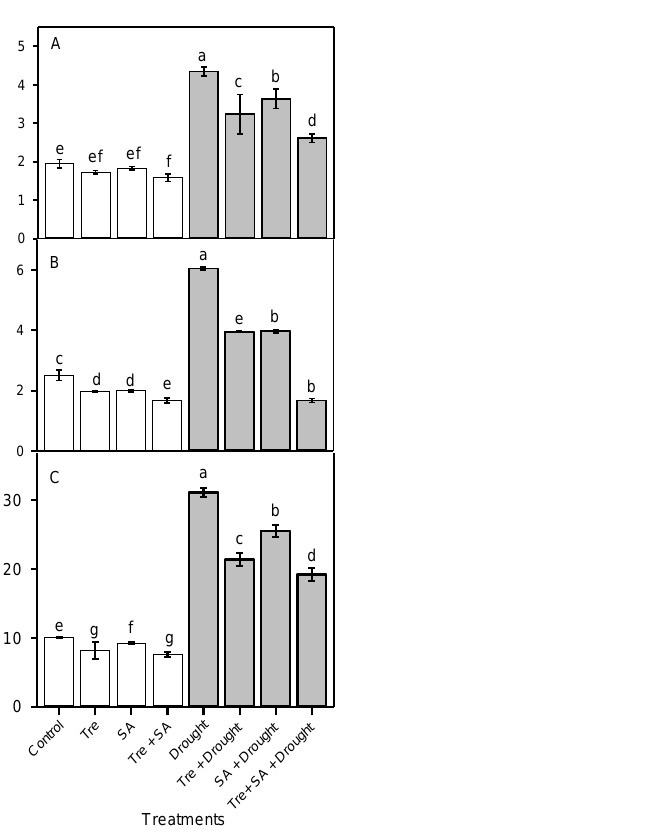
Figure 3. Malondialdehyde concentration (MDA) ( A ), hydrogen peroxide concentration (H 2 O 2 ) ( B ), and electrolyte leakage (EL) ( C ) of sweet basil ( Ocimum basilicum ) after foliar application of 30 mM trehalose (Tre) and/or 1 mM salicylic acid (SA) during drought stress. One month old seedlings were watered to 100% (control) or 60% (drought) field capacity for 20 days. Tre and/or SA were then applied twice with a 5 day interval. The watering conditions were maintained for an additional 2 weeks until plants were harvested. Data are the means ± SE ( n = 6). Different letters above the bars indicate significant differences among means according to Duncan’s multiple-range test at the p < 0.01 level. Drought stress induced CAT, SOD, and POD activities by 79%, 31%, and 94%, re- spectively, compared to well-watered control seedlings (Figure 4). Application of Tre fur- ther increased CAT activity by 21%, SOD activity by 14%, and POD activity by 25% in drought-stressed seedlings over untreated drought-stressed seedlings. Foliar application of SA increased CAT, SOD, and POD activities by 16%, 12%, and 26%, respectively, com-